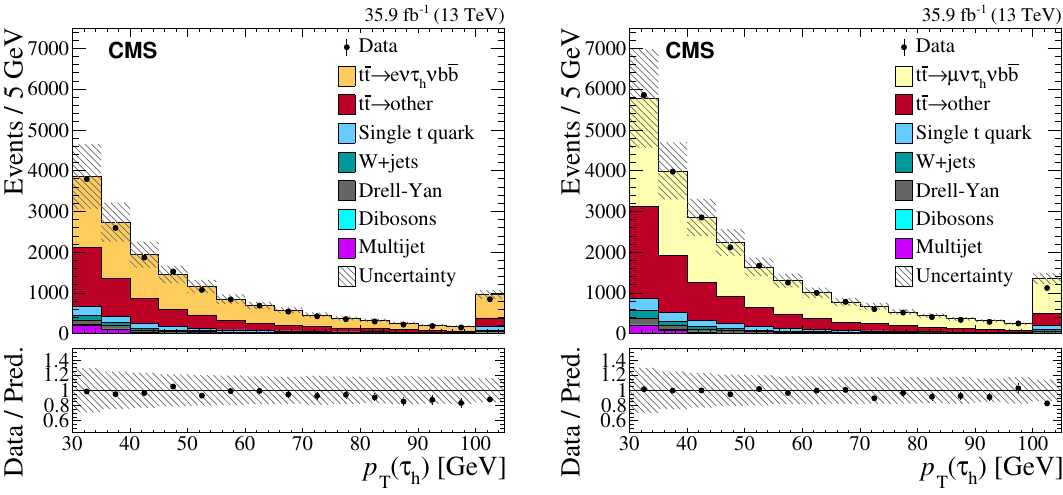
Figure 1. The t p distributions for events of the e t (left) and mt (right) (cid:12)nal states observed T h h h prior to (cid:12)tting. Distributions obtained from data ((cid:12)lled circles) are compared with simulation (shaded histograms). The last bin includes over(cid:13)ow events. The simulated contributions are nor- malized to the cross section values predicted in the SM. The main processes are shown: the signal, the other tt processes grouped together, single top quark production, W+jets, DY processes, dibo- son, and multijet production. The ratio of the data to the total SM prediction is shown in the lower panel. The hatched bands indicate the systematic uncertainties and the statistical uncertainties of all simulated samples. Statistical uncertainties on the data points are not visible because of the scale of the